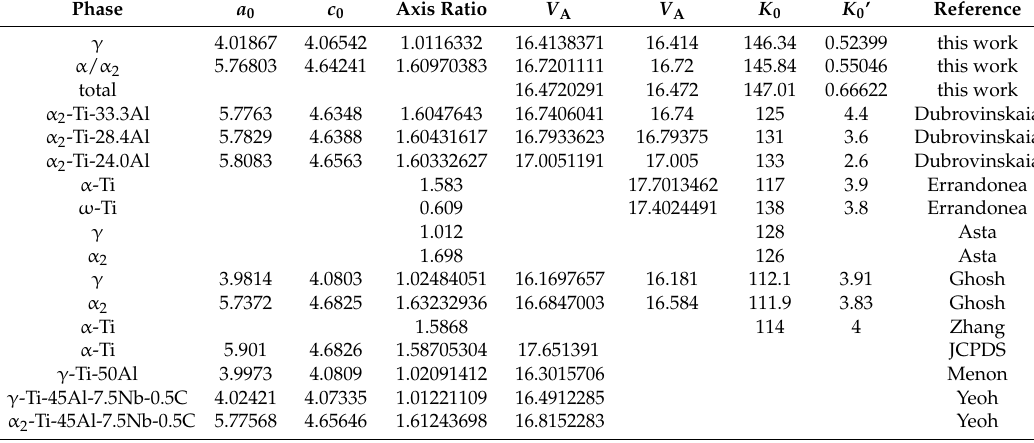
Figure 9. Atomic volumetric compression behavior of the investigated composition Ti-45Al-7.5Nb-0.25C with Birch–Murnaghan fits (experimental dots with continuous lines), as compared to α 2 -single-phase compression, and α - and ω -titanium, reported by Dubrovinskaia [59] and Errandonea [48], respectively. Table 1. Compilation of experimental lattice parameters a 0 and c 0 under ambient conditions, as well as the derived quantities; their axis ratios and volume per atom V A , compression parameters K 0 , K 0 ’ (first three rows) and data from the literature. The α -phase lattice is given in α 2 cell notation, and therefore, 2 c / a is noted. The first V A column is computed from a 0 and c 0 , while the second results are from the fit of pressure data to Equation (6). The original data of Yeoh’s publication [31] has been re-visited to extract the listed values at 300 K. Literature values are reported from their experimental findings, in addition to Ghosh’s first-principles study [61]. Further listed references are Dubrovinskaia [59], Errandonea [48], Asta [60], Zhang [55], JCPDS [56], and Menon [78]. a , c in (Å); V in (Å 3 ); K 0 in (GPa).